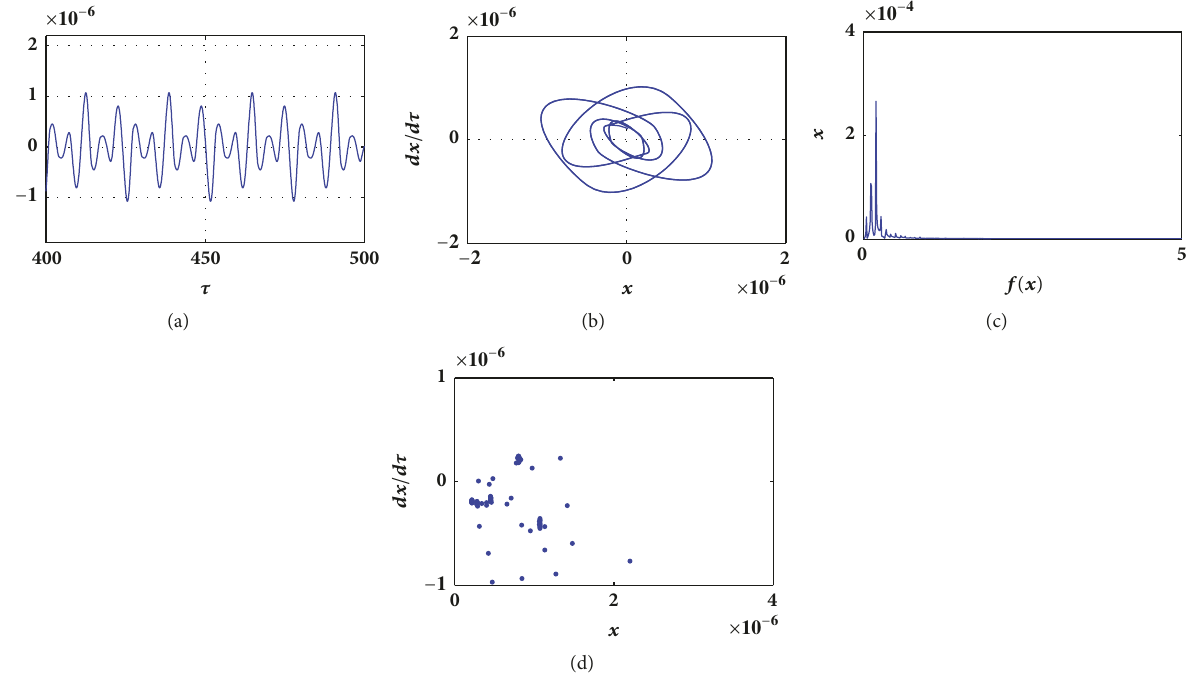
temperature. The larger disturbed parameter induced